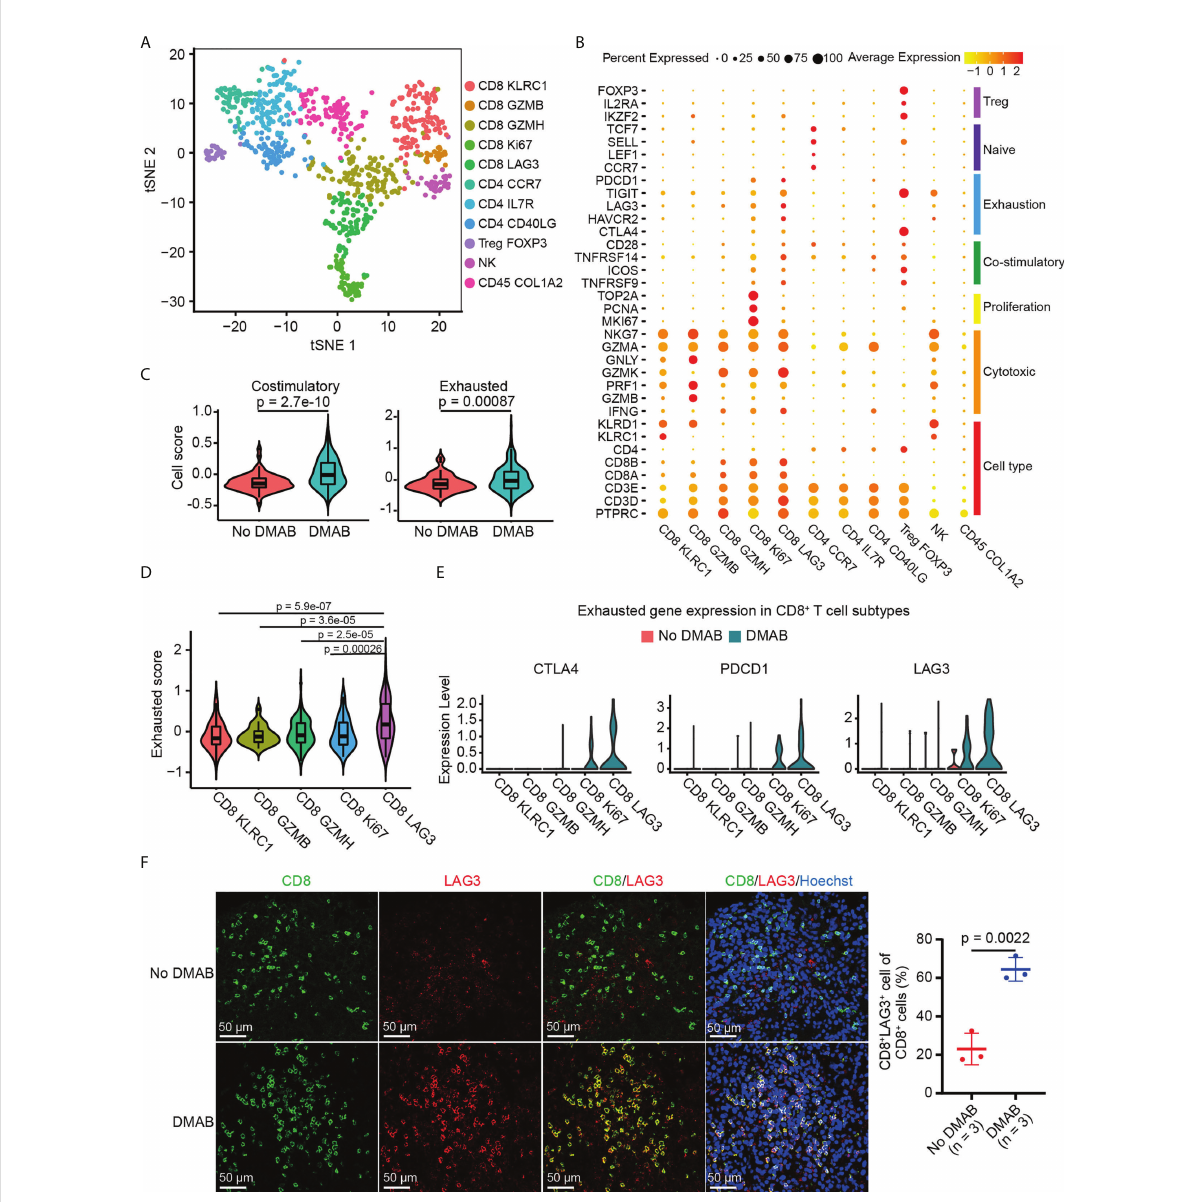
FIGURE 2 DMAB treatment promotes the exhaustion of CD8 + lymphocyte activating 3 (LAG3) + T cells in GCTB. (A) t-SNE plot showing the subtypes of tumor-in fi ltrating lymphocytes (TILs) derived from untreated and DMAB-treated patients with GCTB. (B) Dot plot showing the expression levels of selected gene sets in each subtype of TILs, including Treg, naive, exhaustion, costimulatory, proliferation, and cytotoxic cell types. (C) Violin plot showing the costimulatory and exhausted scores of CD8 + T cells from the No DMAB (red) and DMAB (blue) samples. The p values are calculated by Student ’ s t test. (D) Violin plot indicating the exhausted scores in CD8 + T cell subtypes. The p values are calculated by Student ’ s t test. (E) Violin plot showing the expression levels of selected exhausted genes in CD8 + T cell subtypes. Red, No DMAB; blue, DMAB. (F) Immuno fl uorescence (IF) staining of CD8 and LAG3 antibodies, showing the in fi ltration of CD8 + LAG3 + T cells in unpaired patients with GCTB with (n = 3) or without (n = 3) DMAB. Scale bars = 50 m m. Based on the IF staining results, the in fi ltration ratio of CD8 + LAG3 + T cells was statistically analyzed using an unpaired t